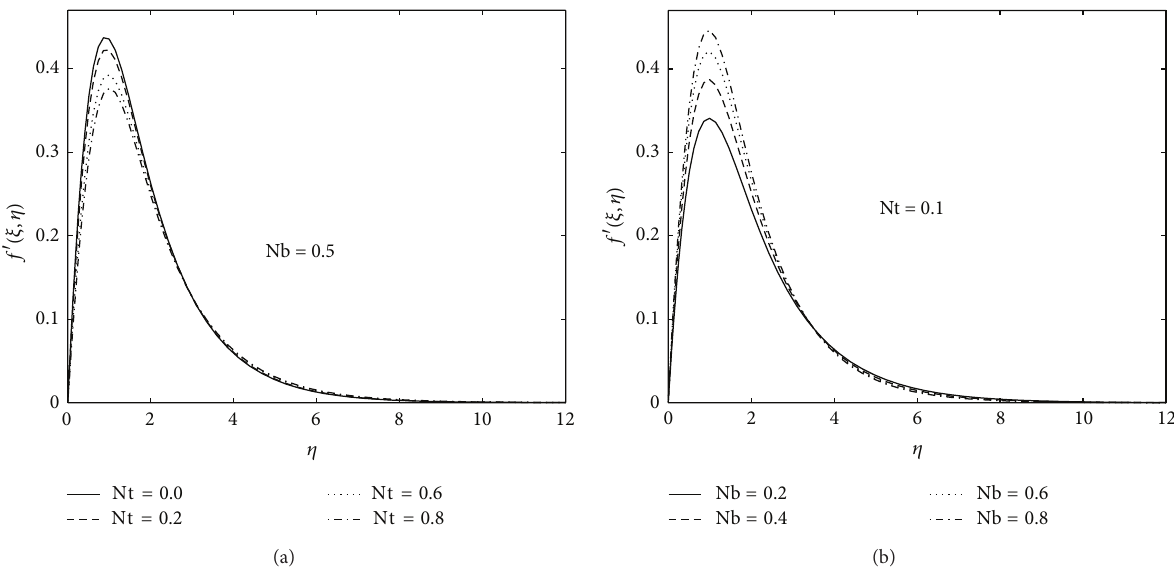
Figure 4: Effect of the Nt on 𝑓 󸀠 (𝜂) for 𝜉 = 0.5 , Le = 10 , Pr = 7 , 𝜎 = 0.3 , Nr = 0.1 , and 𝐴 = 0.1